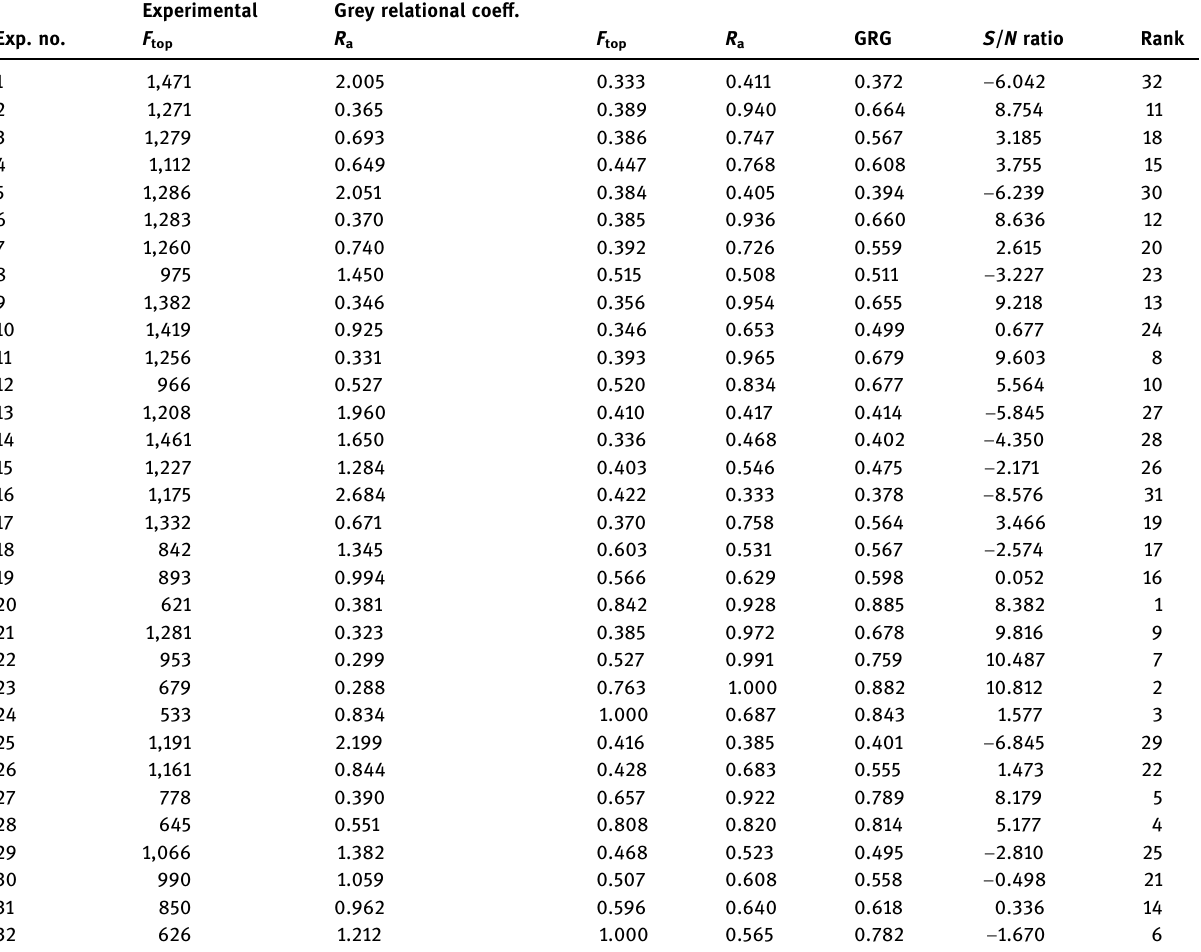
Table 6: Results of GRA Experimental Grey relational coe ff .